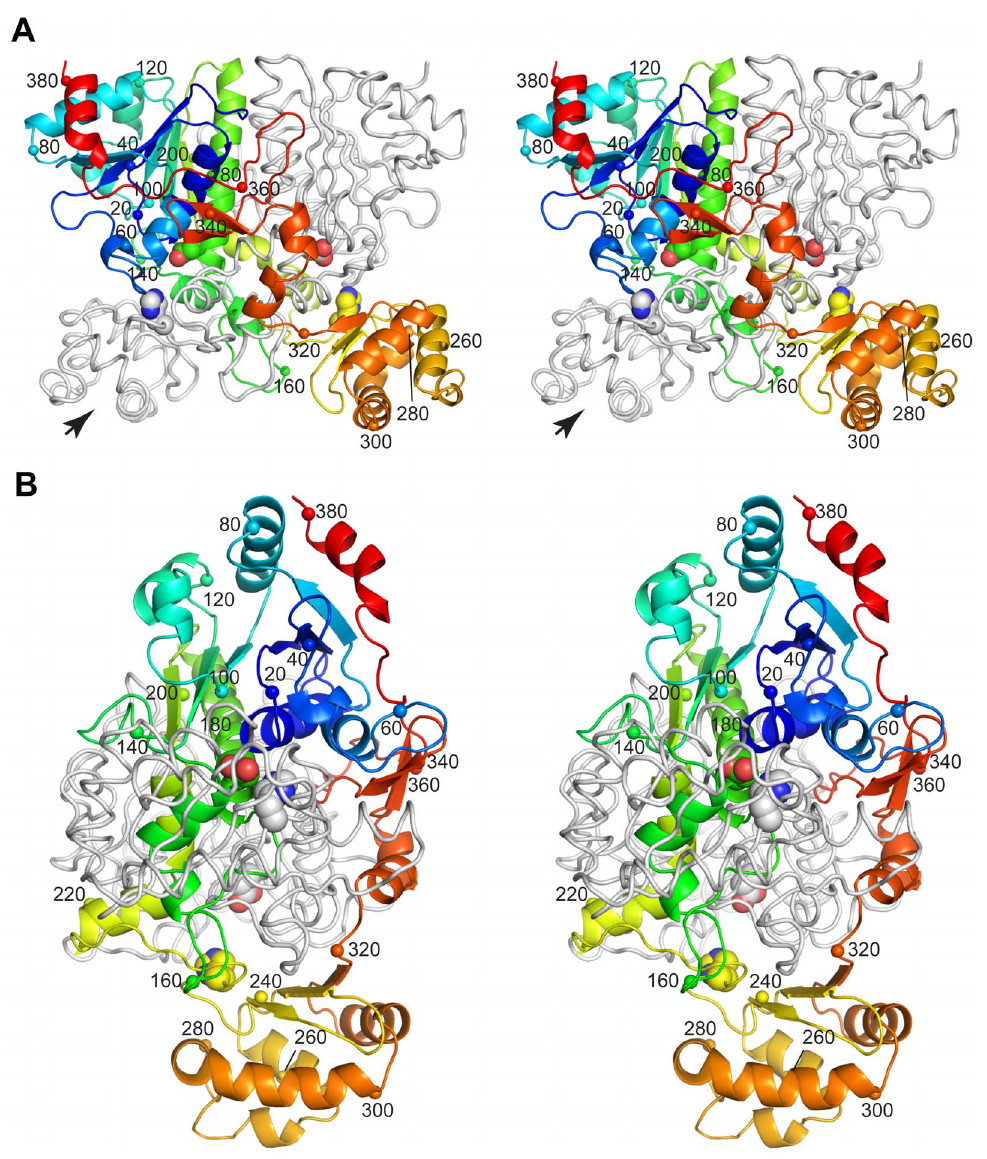
Figure 4. Stereogram of the H6YfdE dimer. One subunit is shown as a rainbow-colored cartoon where the color gradient corresponds to the sequence; the small domain is at the bottom. The other subunit is shown as a light gray ribbon. Small spheres and numbers identify the a -carbon at intervals of 20 residues. The active site residues Asp173 and His233 (large spheres) are provided by different subunits in each active site. A topology diagram is provided in the Supporting Information (Figure S5). (A) View with the pseudo-twofold axis relating the subunits vertical in the plane of the page. Spheres corresponding to residues 220 and 240 are hidden by the partner subunit. (B) View along the long axis of one subunit as indicated by the large arrow in panel